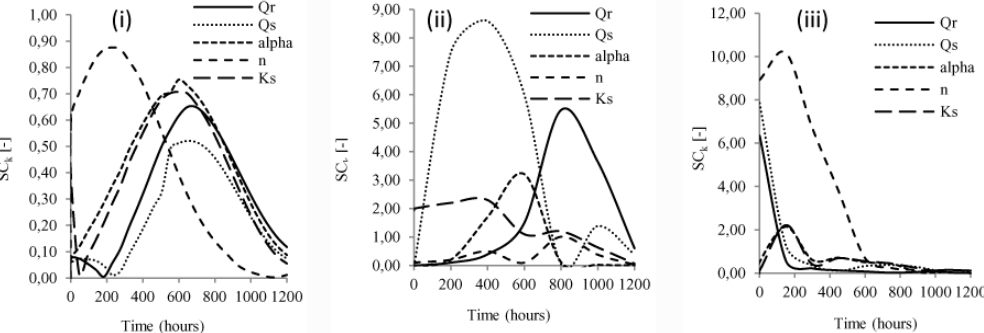
Fig. 9. Sensitivity coefficients (SCs) of the average hydraulic conductivity ( k ) to van Genuchten–Mualem model parameters for the Tukulu (i), Sepane (ii) and Swartland (iii)